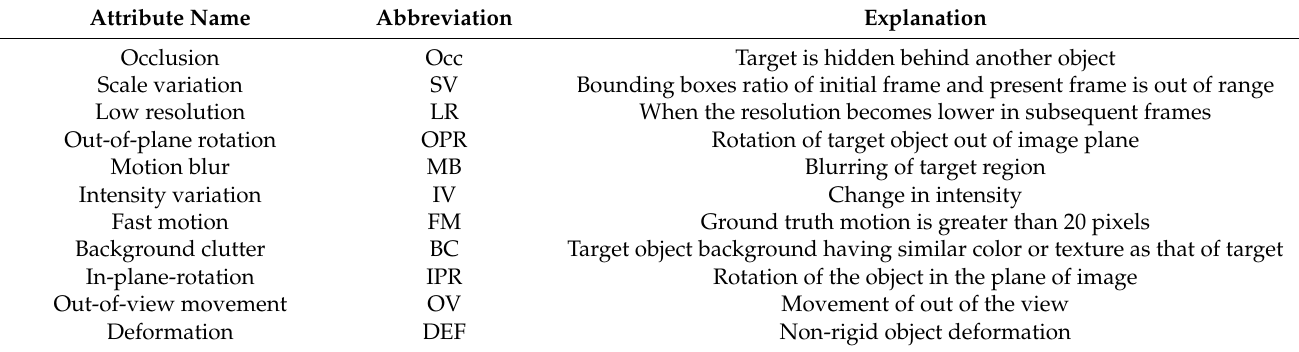
Table 2. Explanation of challenges associated with video